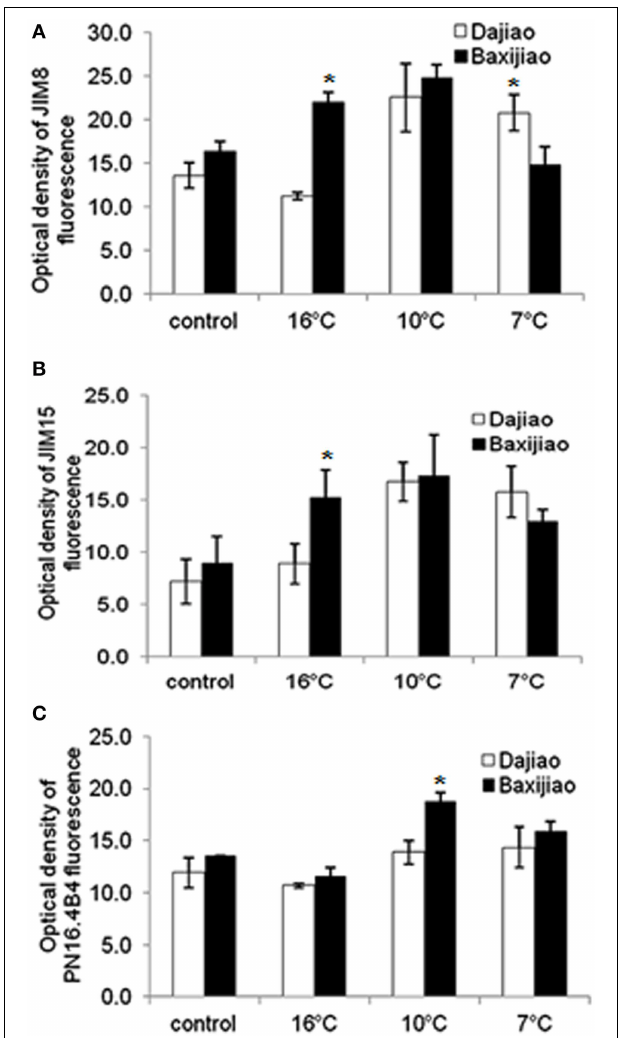
FIGURE 7 | The optical density of the fluorescence signal of arabinogalactan proteins labeled by JIM8, JIM15 and PN16.4B4 antibodies in banana ( Musa spp.) leaves after low temperature stress. (A) JIM8; (B) JIM15; (C) PN16.4B4. Dajiao: a Musa spp. ABB cultivar, chilling-tolerant; Baxijiao: a Musa spp. AAA cultivar, chilling-sensitive. Values marked with star were considered significant at P < 0 . 05 while values marked with two stars were considered significant at P < 0 . 01 .